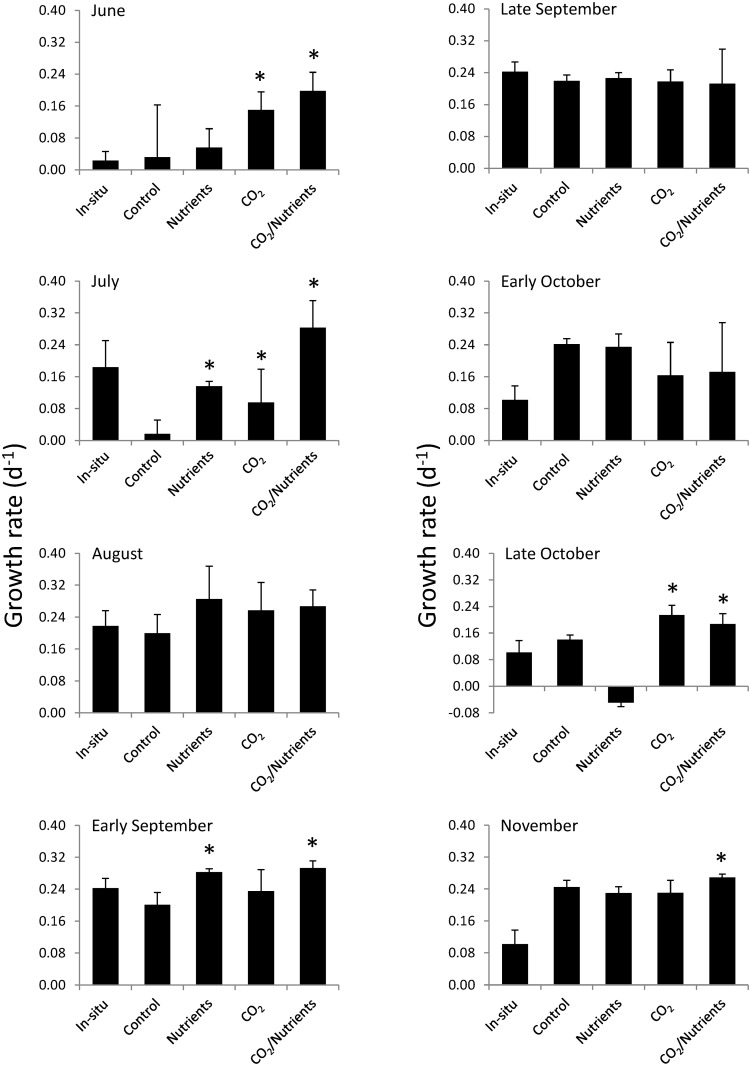
Ulva growth rates.Growth rates of Ulva exposed to ambient and elevated CO2 conditions with and without nutrient additions for experiments performed August through November. Columns with an asterisk over them indicate significant results.